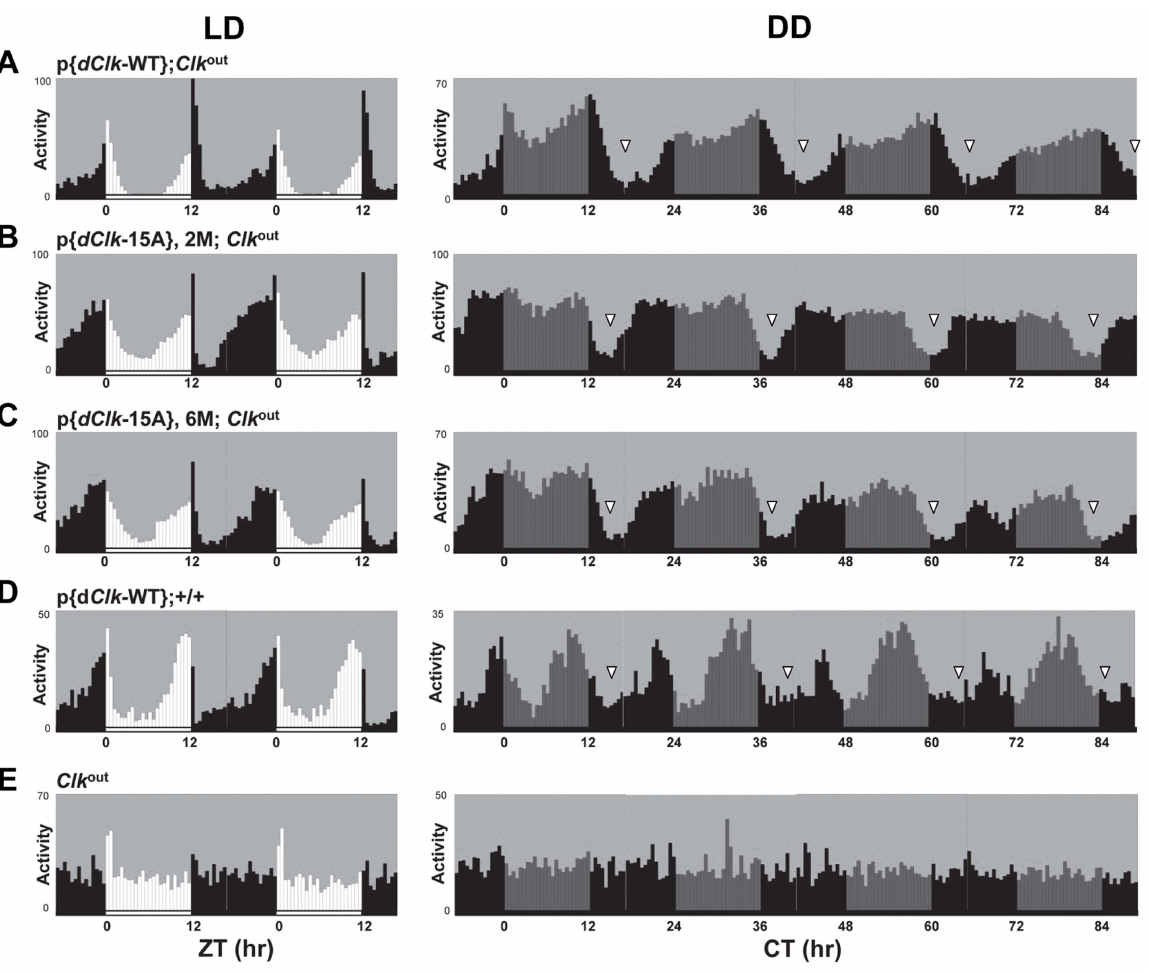
Figure 2. (A–E) The p{ dClk -15A}; Clk out flies manifest short period behavioral rhythms. Each panel represents the average activity of male flies for a given genotype during the third and fourth day of 12 hr light:12 hr dark entrainment (LD) followed by 4 days of constant darkness (DD). White vertical bars represent locomotor activity during light phase and black vertical bars represent locomotor activity during dark phase in LD. Gray vertical bars represent locomotor activity during the subjective light phase in DD. White horizontal bars and black horizontal bars below each panel indicate 12 hr periods of lights-on and lights-off, respectively. Arrowheads indicate the times in a daily cycle when trough levels of activity were attained following the evening bout of activity. Standard error of the mean is indicated as dots above each